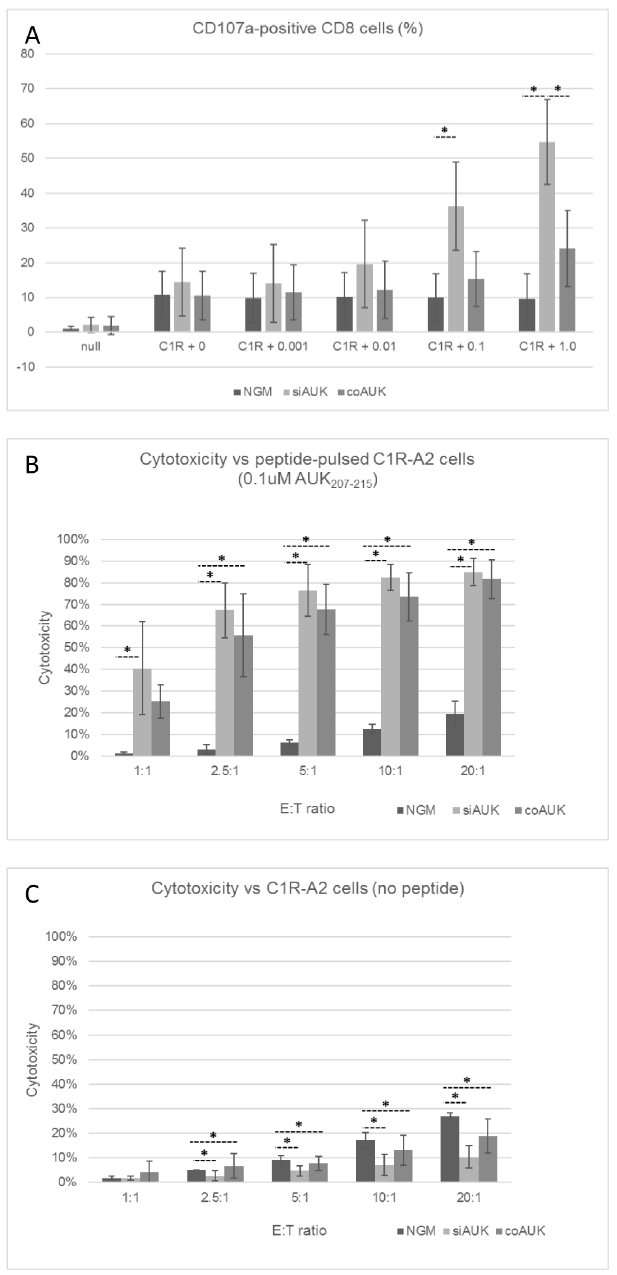
Fig 2. Sensitivity and Cytotoxicity by CD8+ cells in response to peptide-loaded target cells. CD8+ cells were transduced with siAUK or coAUK vectors, and enriched on the basis of V β 12 expression. NGM cells were used as a negative control. (A) To measure CD107a degranulation, C1R-A2 cells were pulsed with the indicated concentration of AUK 207-215 peptide. Effector cells were co-cultured with target cells at E:T = 2:1. CD107a-APC antibody was added prior to 3 hours co-culture. CD107a labelling was assessed by FCM, and is presented as a percentage of CD8+ cells. For Chromium-release assessment of total cell killing, TCR- enriched T cells were co-cultured at a range of E:T ratios for 4 hours with Cr 51 -labelled, C1R-A2 target cells that were pulsed (B) or not pulsed (C) with 0.1 μ M AUK 207-215 ( * p < 0.05, One-way ANOVA with Tukey ’ s test, n = 3, ±